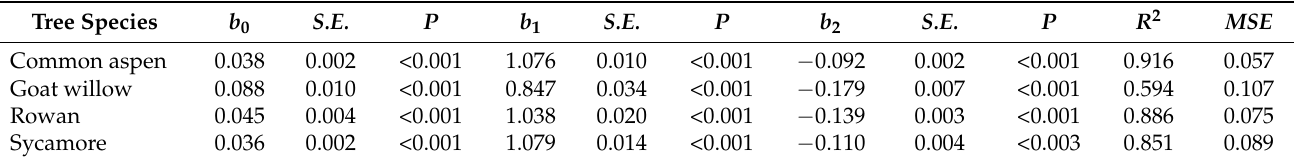
Table 3. Relationships of stem radius r at a specific height from the ground to stem base diameter D 0 and the distance from the ground ( H g ) for four broadleaved tree species described by the formula: errors ( S.E .), p -value ( P ), coefficient of determination ( R 2 ), mean squared error ( MSE